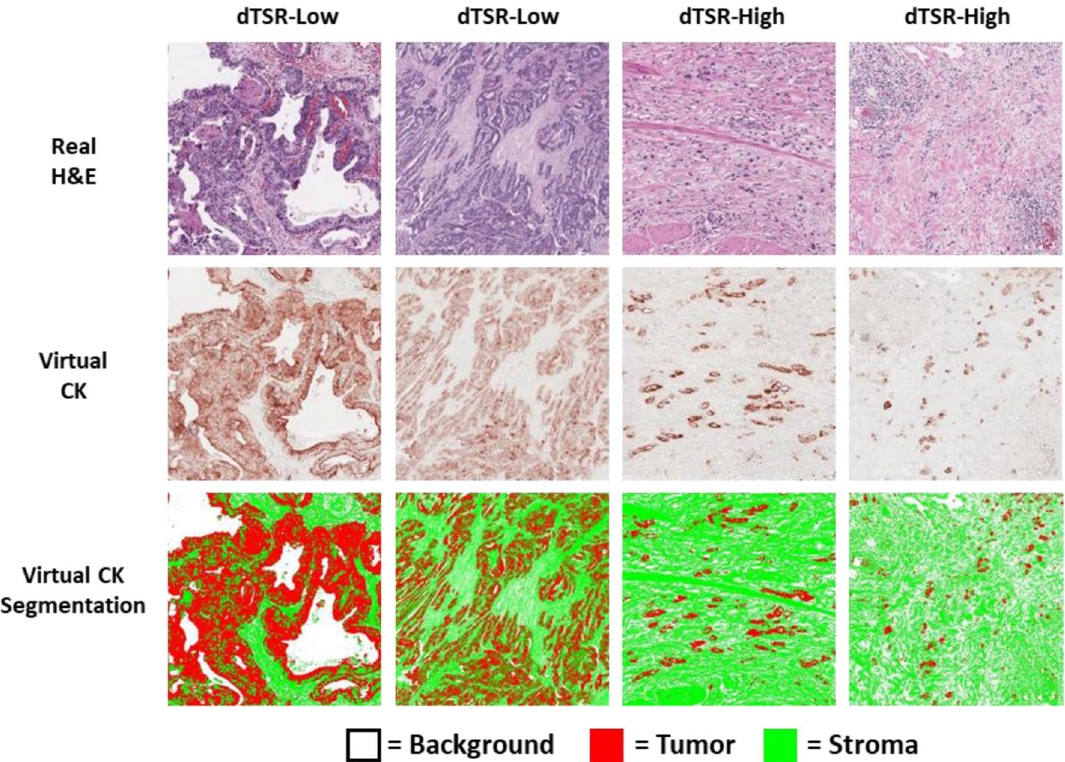
Figure 6. Tumor and stroma segmentation results on virtual CK images that were transformed from hematoxylin and eosin (H&E)-stained images on the hotspots of tumor–stroma ratio (TSR) assessment. The two columns on the left are images of dTSR-low, whereas the two columns on the right are images of